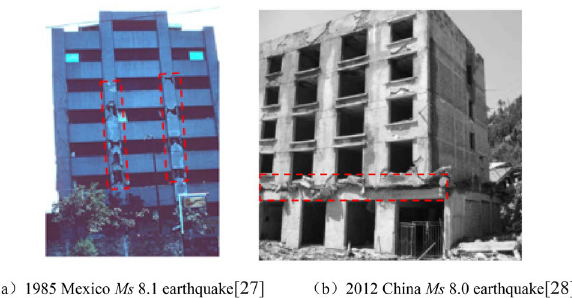
Figure 7. Examples of earthquake damage in the middle of multi-storey